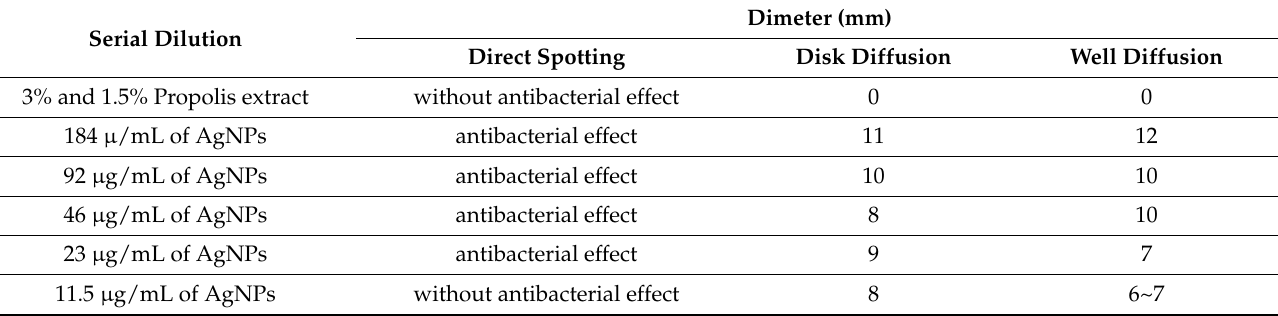
Table 1. Zone of inhibition obtained though the direct spotting, disk and well diffusion